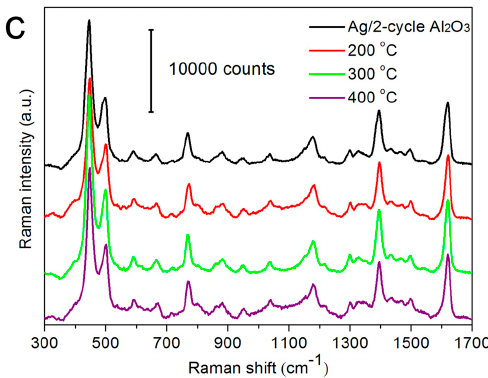
Figure 3. ( a ) SEM images of AgNR arrays coated with Al 2 O 3 layers by 1 and 2 ALD cycles after annealing at 300 and 400 °C; Raman spectra of 5 × 10 − 6 M MB adsorbed on AgNRs substrates coated with Al 2 O 3 layers by ( b ) 1 ALD cycle and ( c ) 2 ALD cycles, before/after annealing at 200, 300, and 400 °C, respectively (Reprinted with permission from [49]).